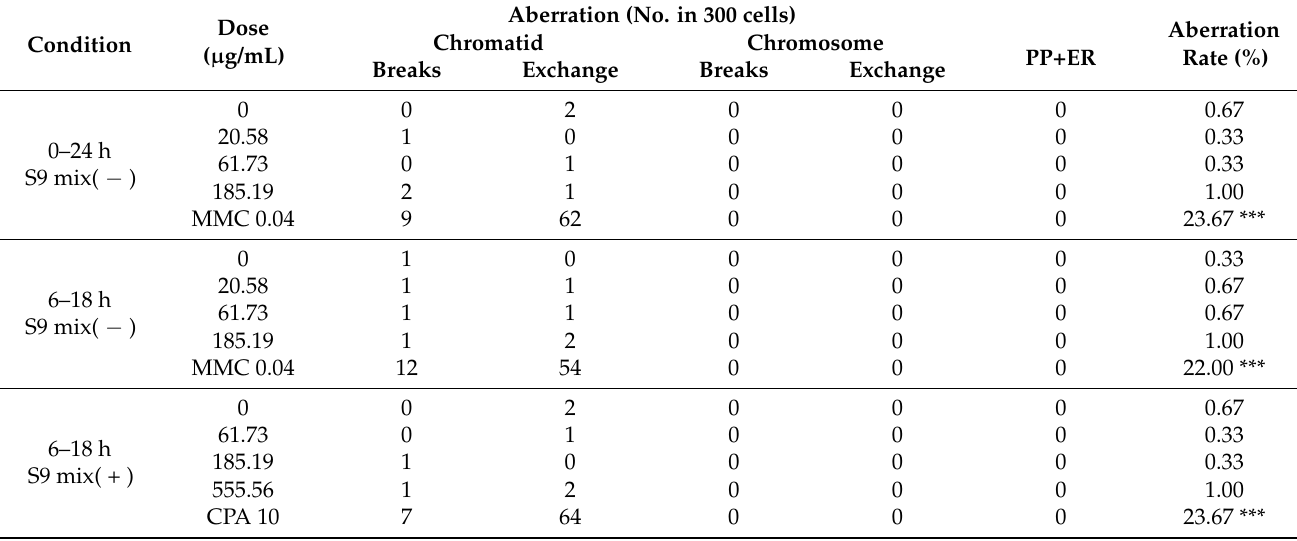
Table 2. Chromosomal aberrations by Rhus verniciflua Stokes without bark (RVX) with or without S9 activation.